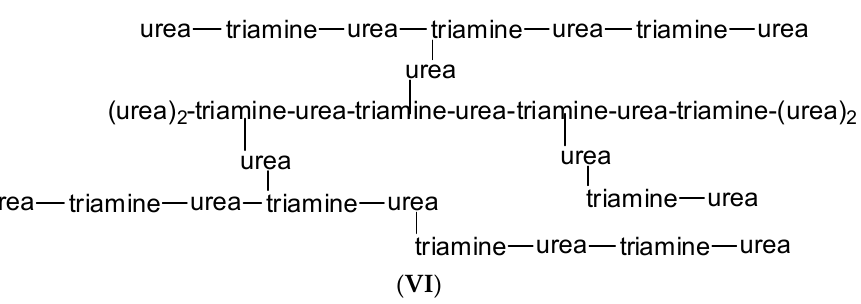
Figure 8. A higher molecular weight structure of the tramine-ureahyperbranched network.